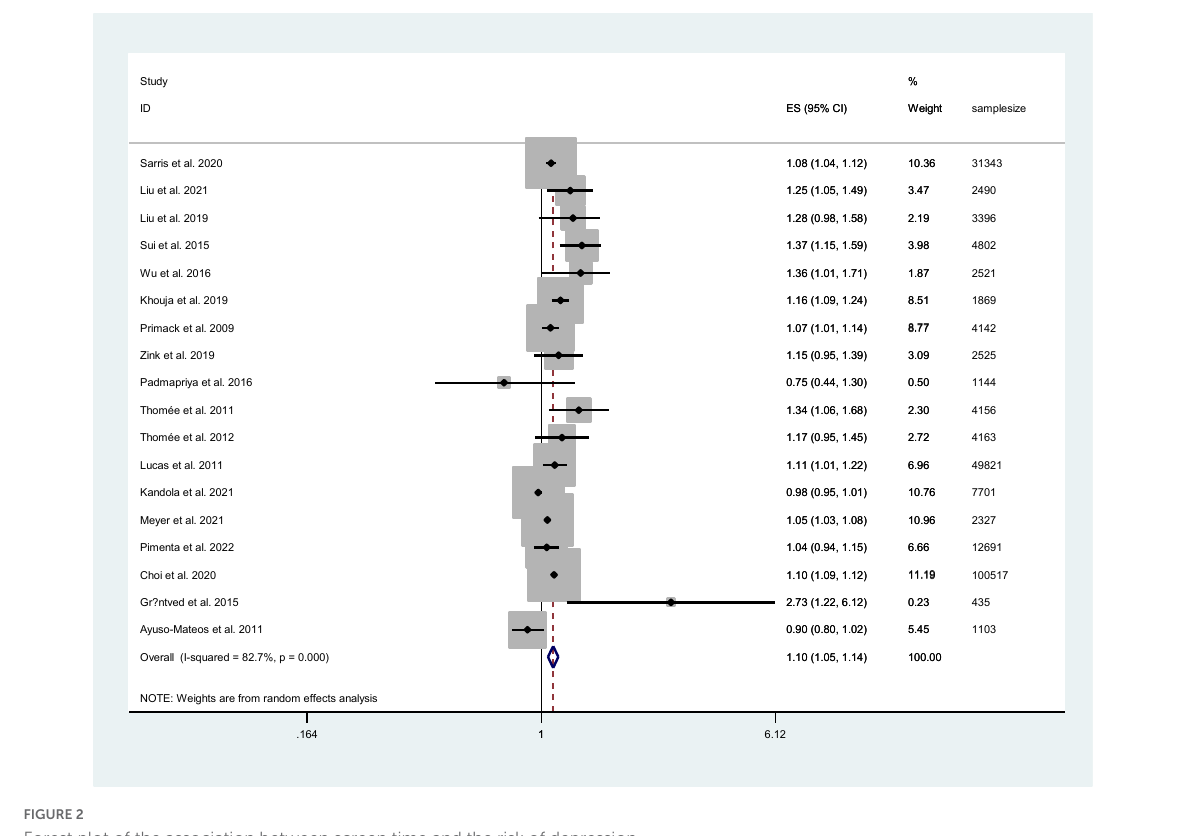
analyses suggested a significantly positive association between screen time and depression risk (RR = 1.11, 95% CI: 1.06–1.16, I 2 =